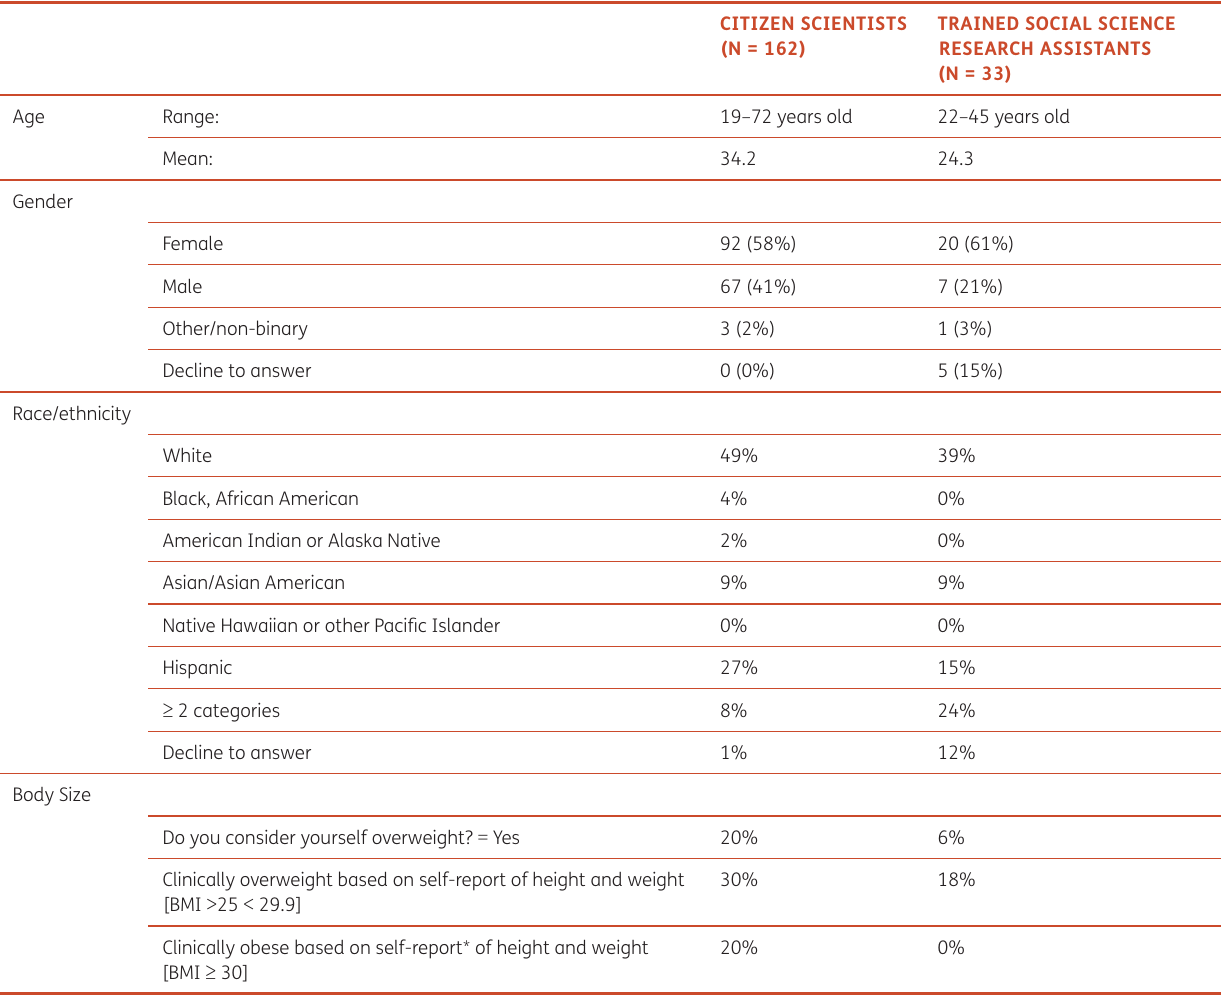
Table 1 Citizen scientist and research assistant demographic information (=162). Notes: Self-reported height and weight found that 50% of the citizen scientists were either clinically overweight or obese based on BMI, although 80% of the volunteers indicated that they did not consider themselves